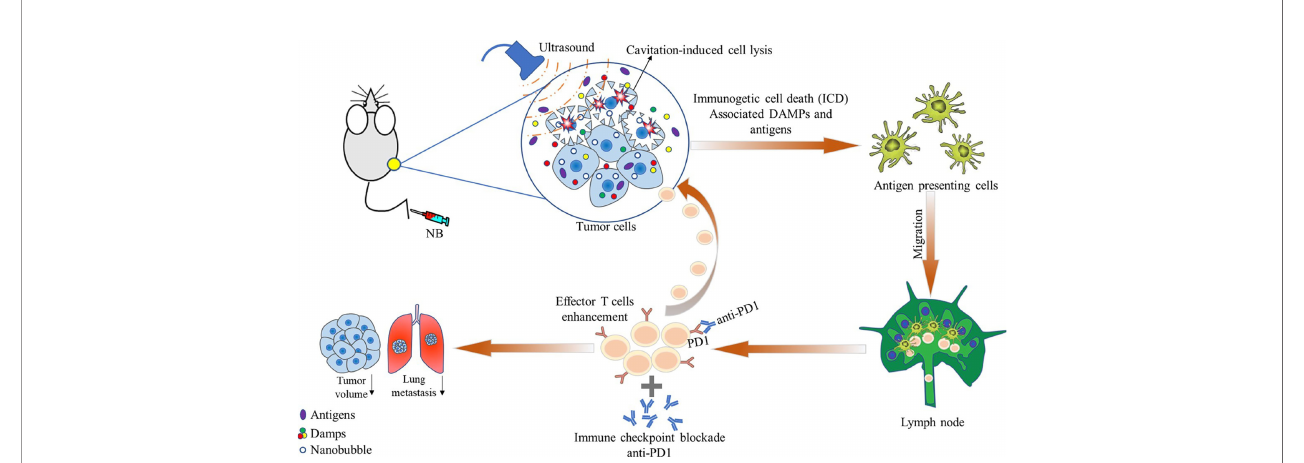
FIGURE 3 | Schematic illustration showing the effects of ultrasound-stimulated nanobubbles (USNBs) on the mouse tumor model. USNBs can induce tumor cell necrosis, which can release immunogenic substances, further activate innate and adaptive immune cells, and fi nally activate CD8+ T cells. This leads to systemic anti-tumor immunity, enhancing the ef fi cacy of anti-PD1 therapy and promoting immune memory. Reprinted (adapted) with permission from ref (18). copyright © 2022 Hu, He, Wang, Zhao, Fang, Dong, Chen, Zhang, Zhang, Wang, Tan, Wang, Zi, Liu, Liang, Guo,